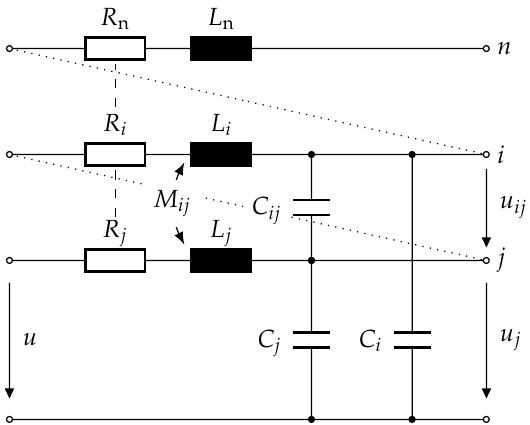
Figure 6. Multi-turn model by connecting n single-turn models in series; the circuit elements are frequency-dependent as shown in Figure 5, and all turns including the n th-turn share mutual inductive and capacitive couplings (not drawn).